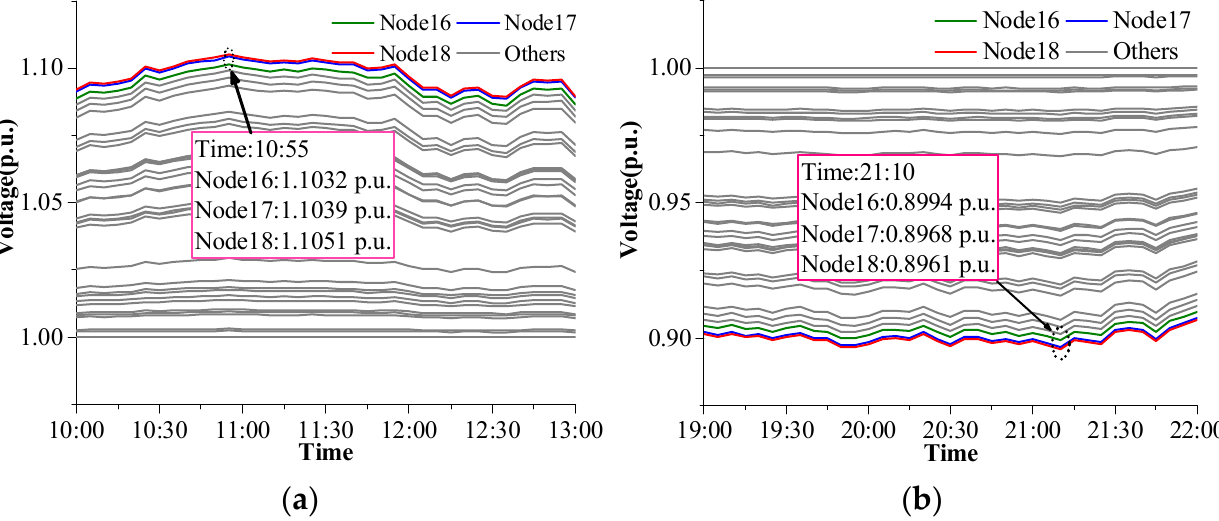
Figure 9. The voltages curves of nodes without any voltage optimization: ( a ) over-voltage problem;